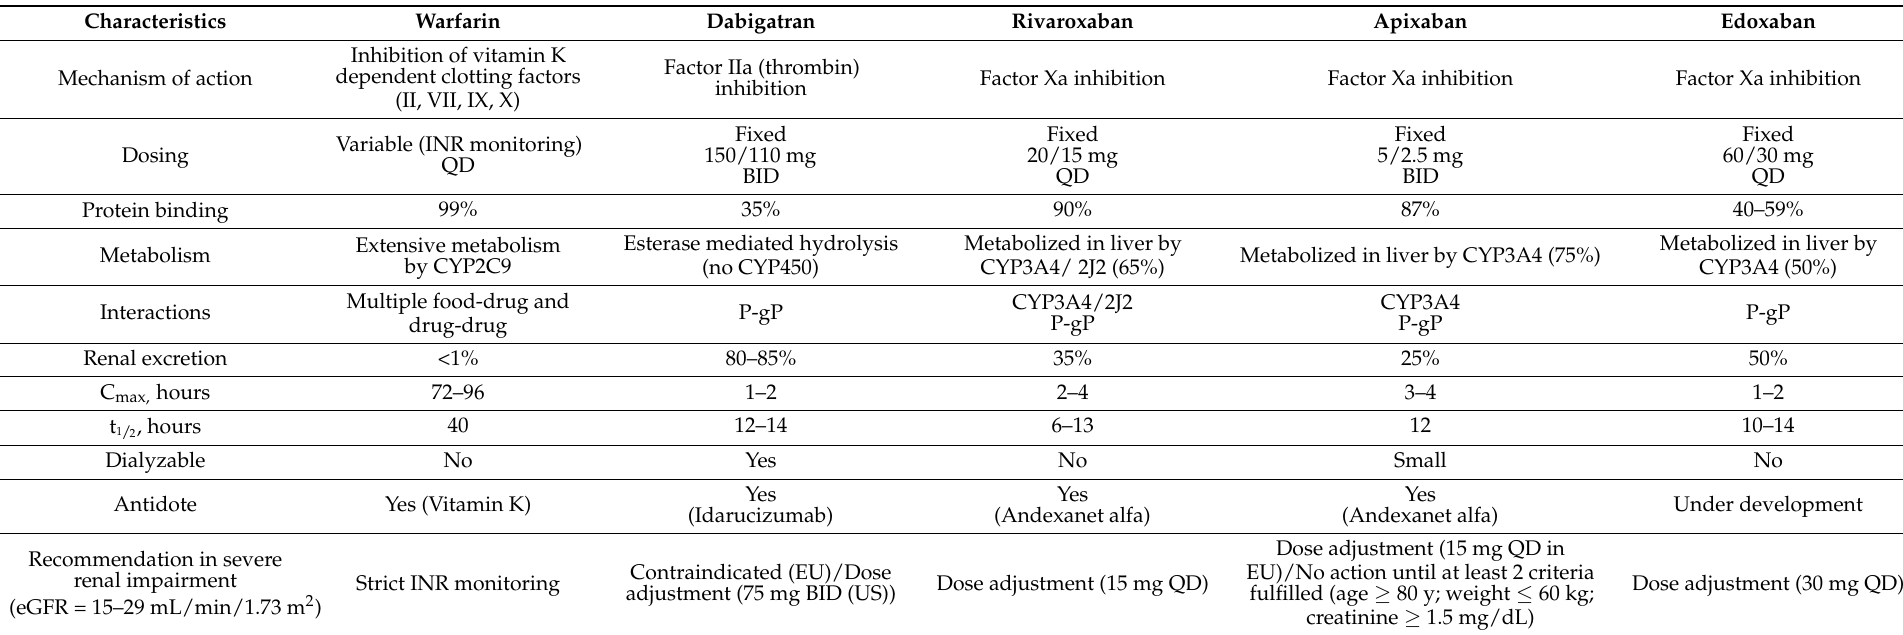
Table 3. Pharmacodynamic and pharmacokinetic properties of commonly used oral